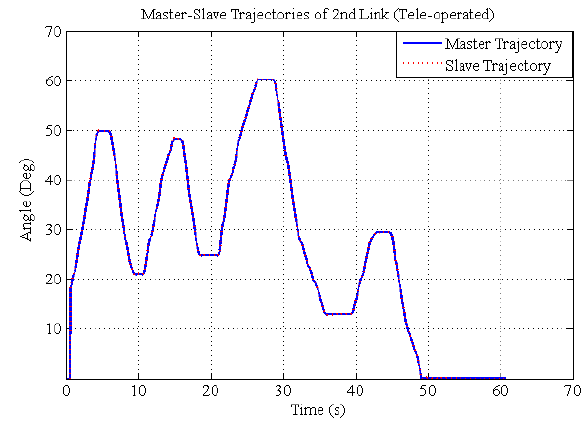
Figure 15. Master / slave trajectories for the 2 nd Figure 15. Master/slave trajectories for the 2 nd link. Figure 15. Master/slave trajectories for the 2 nd link.